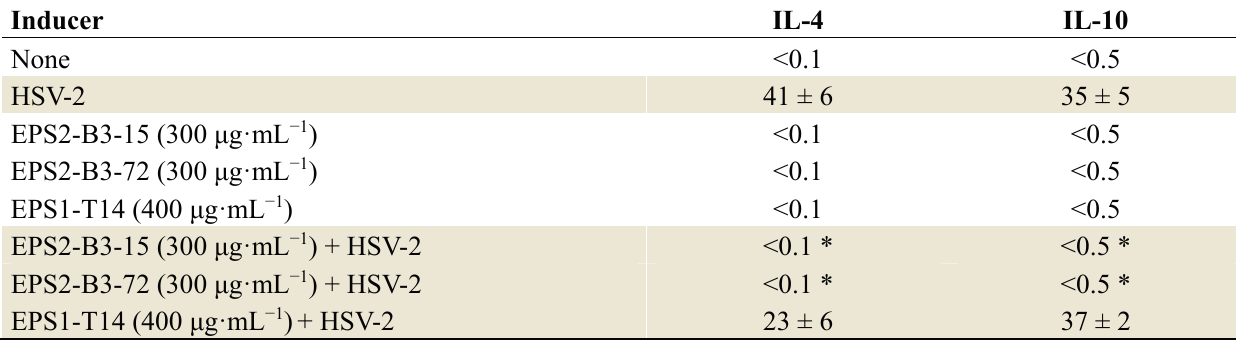
Table 6. Production of Th2 cytokines (IL-4 and IL-10) (pg·mL − 1 ) at 48 h post-EPSs treatments by PBMC and under the effect of HSV-2 infection (in grey). Values are expressed as mean of four experiments ±S.D.